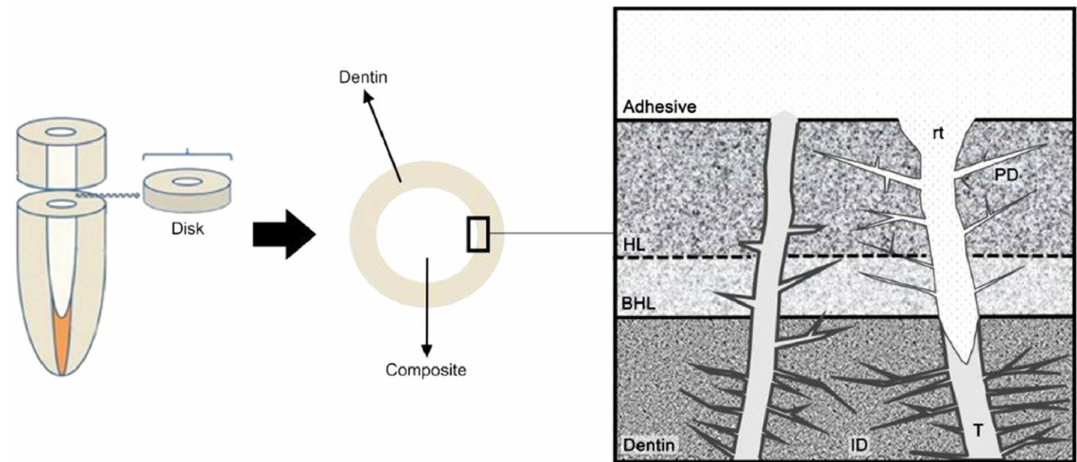
Figure 9. Schematic illustration presenting disks preparation mode and the observation zone (the resin-dentin bonded interface). HL: hybrid layer; BHL: bottom of hybrid layer; PD: peritubular dentin; ID: intertubular dentin; rt: resin tag; T: dentinal tubule. Reproduced with permission from Toledano-Osorio et al.